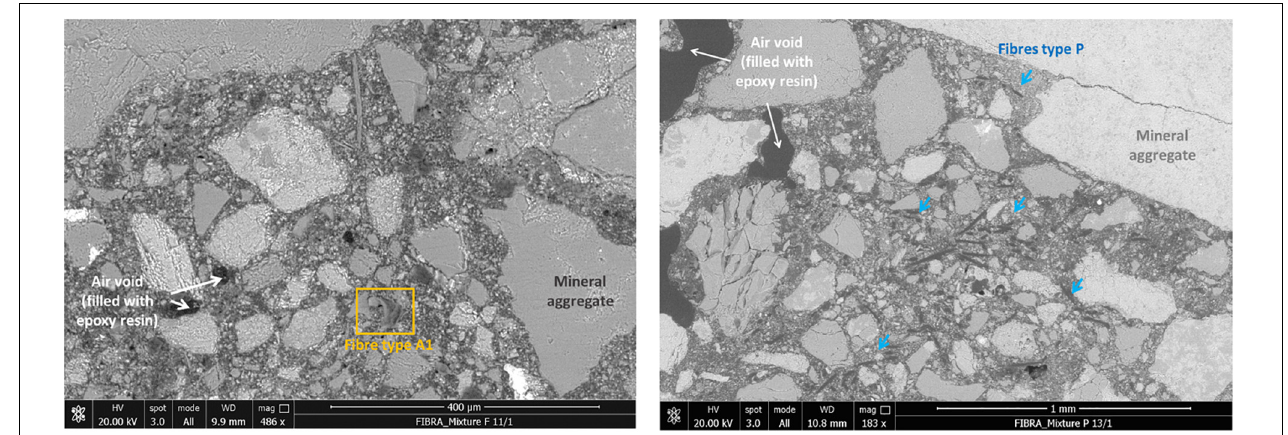
FIGURE 9 | ESEM images of samples from the FRAM with type A fibers (left) and type P fibers (right) . The arrows try to help the analysis by pointing at the fibers (Type P).